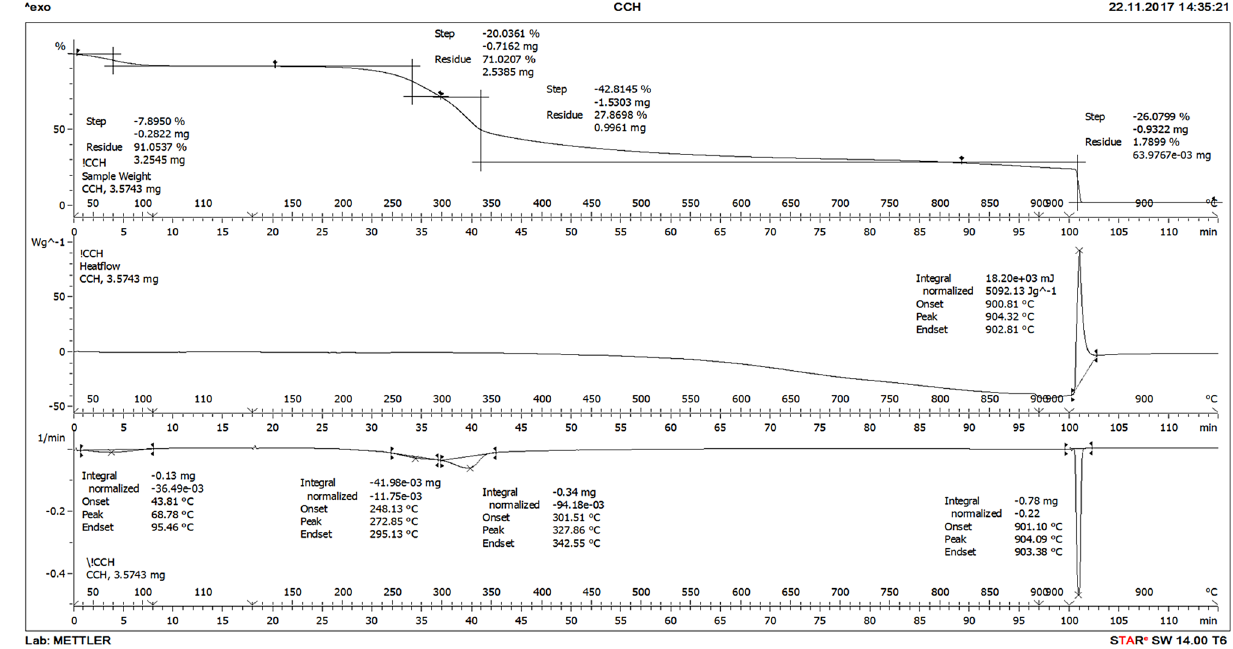
Figure 1. TGA graphs of dried raw eucalyptus wood chips.